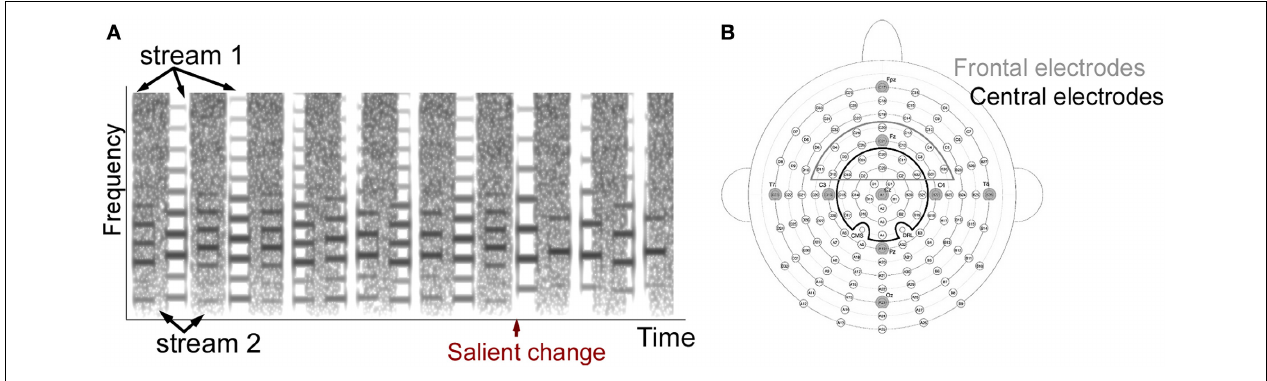
FIGURE 1 | (A) Example stimulus spectrogram used in the two-stream experiments. The spectrogram of one sample trial from the two-stream experiment is shown. The stimulus consists of a musical notes stream and a sequence of noise bursts. The one-stream experiment did not include the